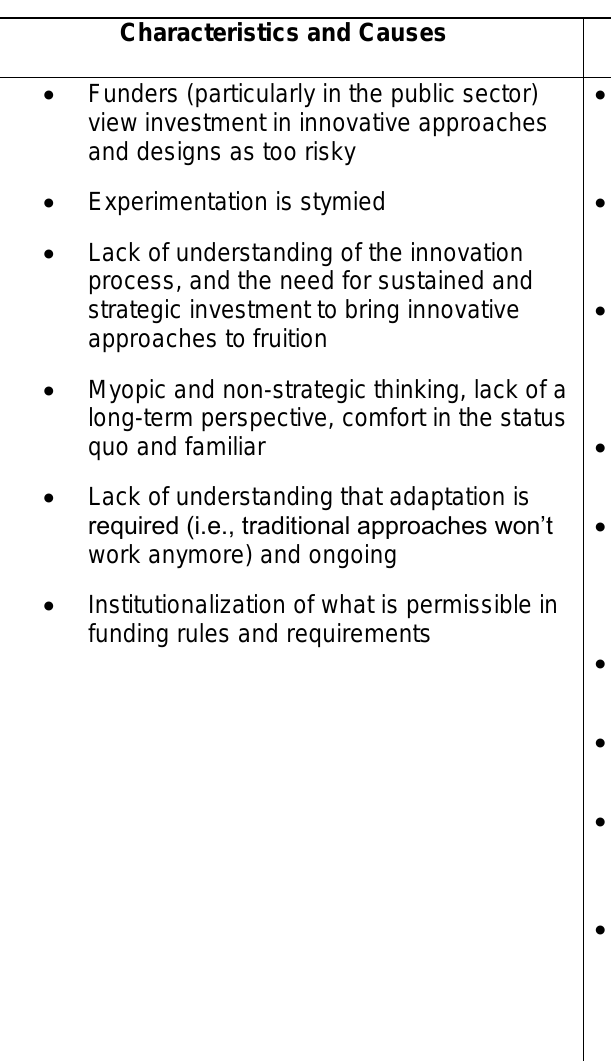
Table A2.12: Characteristics, Underlying Causes and Potential Solutions to Address